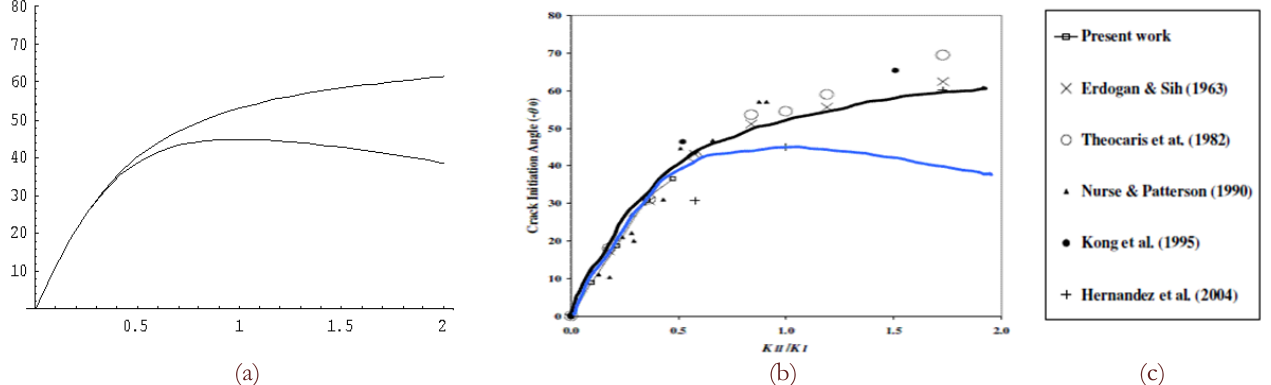
Figure 16: Plots of the kinking angles versus the SIF ratio (a), lower curve: GMax-criterion, upper curve: MTS-criterion. Comparisons of the theoretical curves with experimental results (b). The graph (b) is taken from Al Bib Mousa [13] and “present work” in the legend (c) refers to